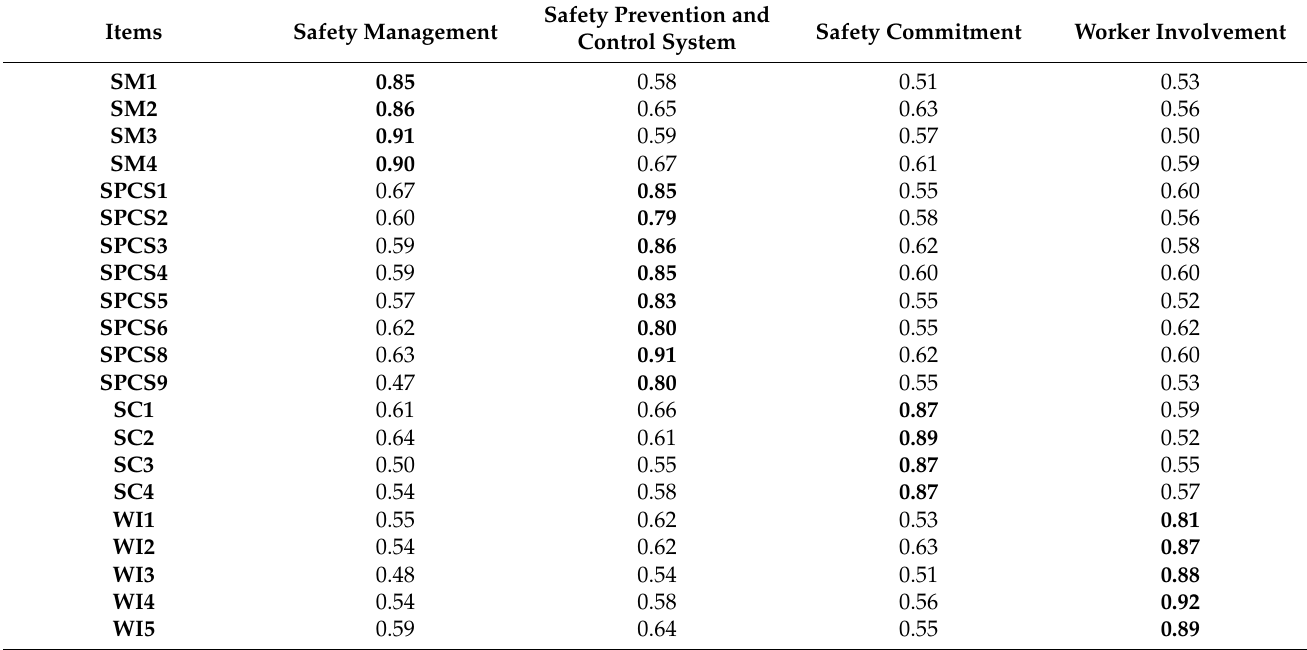
Table 6. Measurement Model Cross-Loading.